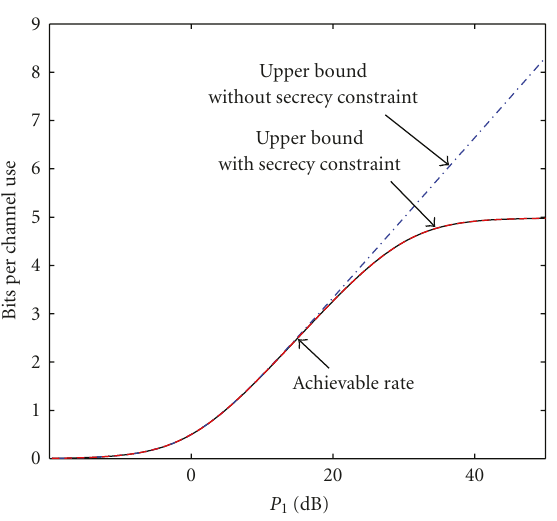
Figure 7: Secrecy Rate, P r → ∞ , P 2 = 30dB, optimal α.